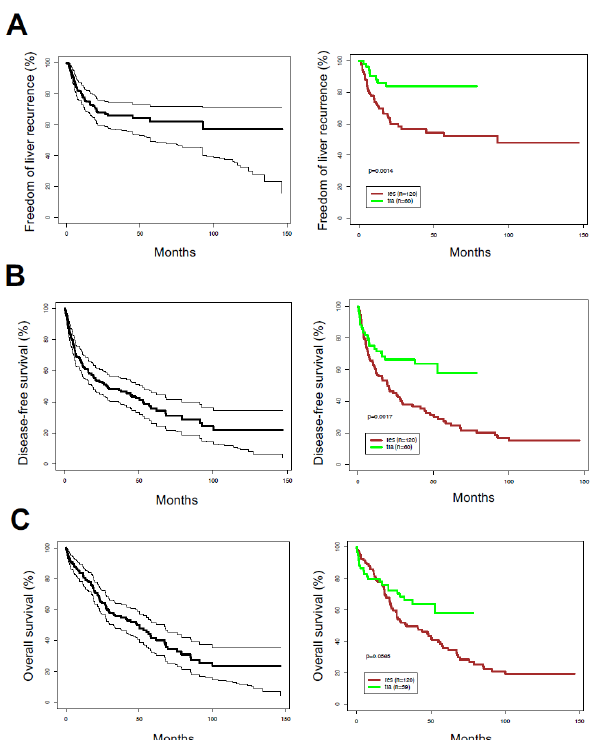
Figure 1. Kaplan – Meier survival distributions in hepatocellular carcinoma patient cohort. ( A ) Freedom of liver recurrence; ( B ) disease-free survival; ( C ) overall survival. p-values are derived from the log-rank test. Left plots show data for all patients, right graphs show data after segregating by surgical treatment: liver resection (res) versus transplantation (tra).